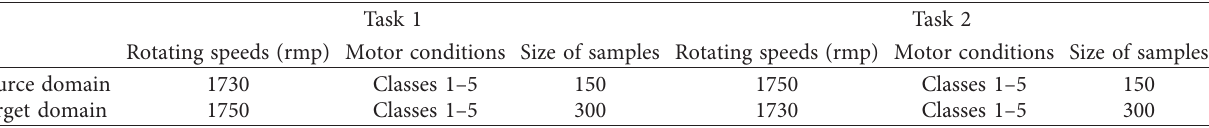
Table 3: 2 cross-domain fault diagnosis tasks for 5 motor conditions.